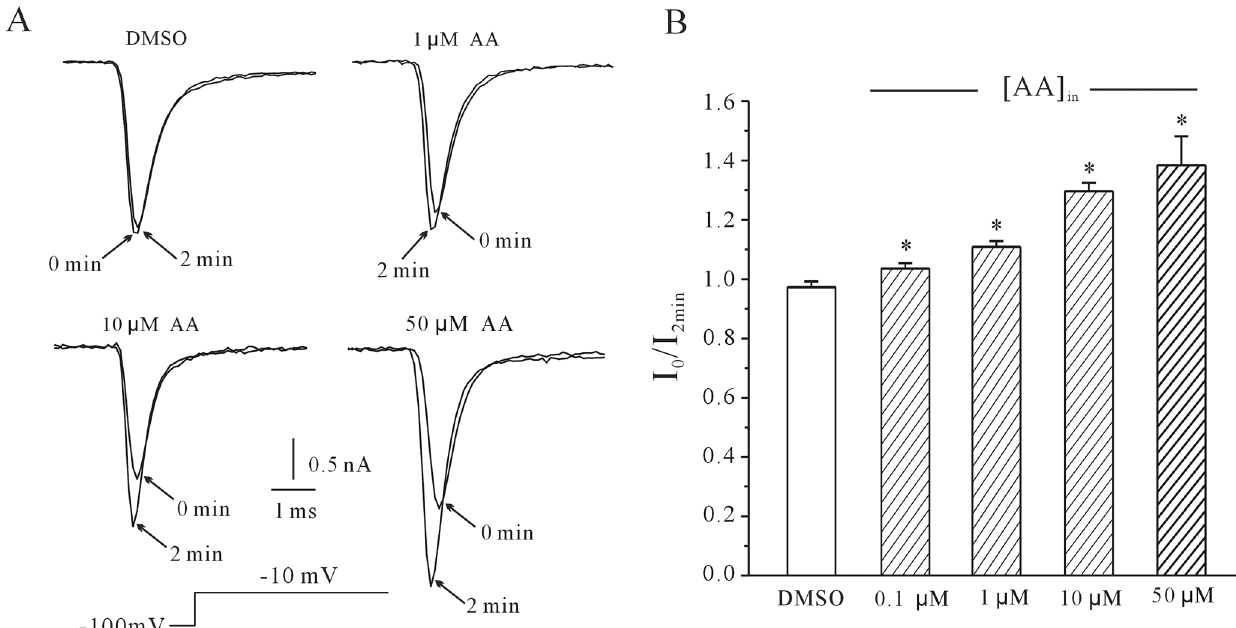
Fig 1. Concentration-dependent increase of rNav1.4 current in response to intracellular application of AA. (A) Superimposed rNa V 1.4 currents evoked by a 10 ms depolarizing pulse from a holding potential of -100 to -10 mV. Current traces were obtained in the absence and presence of intracellular AA at concentrations of 1 μ M, 10 μ M, and 50 μ M. An intracellular solution containing 0.2% DMSO was used as a control and did not affect the rNa V 1.4 current. (B) The activating effect of different AA concentrations (0.1 μ M, 1 μ M, 10 μ M, and 50 μ M) on rNa V 1.4 current. * P < 0.05 compared to control, using a one-way ANOVA